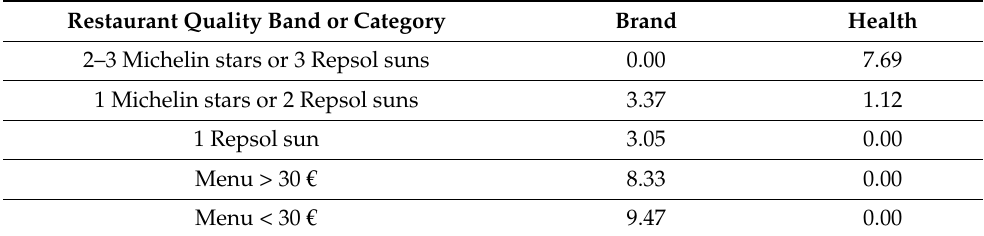
Table 3. Use of the criteria “brand” and “health” in choosing EVOO for dining room purposes (% of subjects who cite each criterion relative to total subjects interviewed in same category).